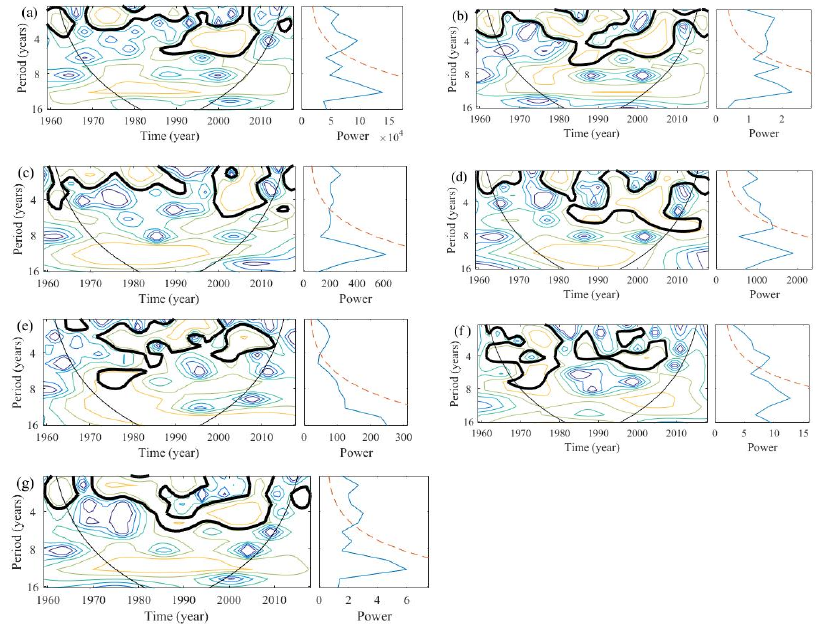
Figure 5. Continuous wavelet transform of PRCPTOT ( a ), SDII ( b ), Rx1day ( c ), Rx5day ( d ), CDD ( e ), CWD ( f ), and R95ds ( g ). The closed areas of the black thick coils passed the standard red noise test at 95% confidence level. The square cone areas below the black thin solid lines were the cone of influence (COI) areas, and they were the areas where the edge effect of the wavelet transform data were more significant.